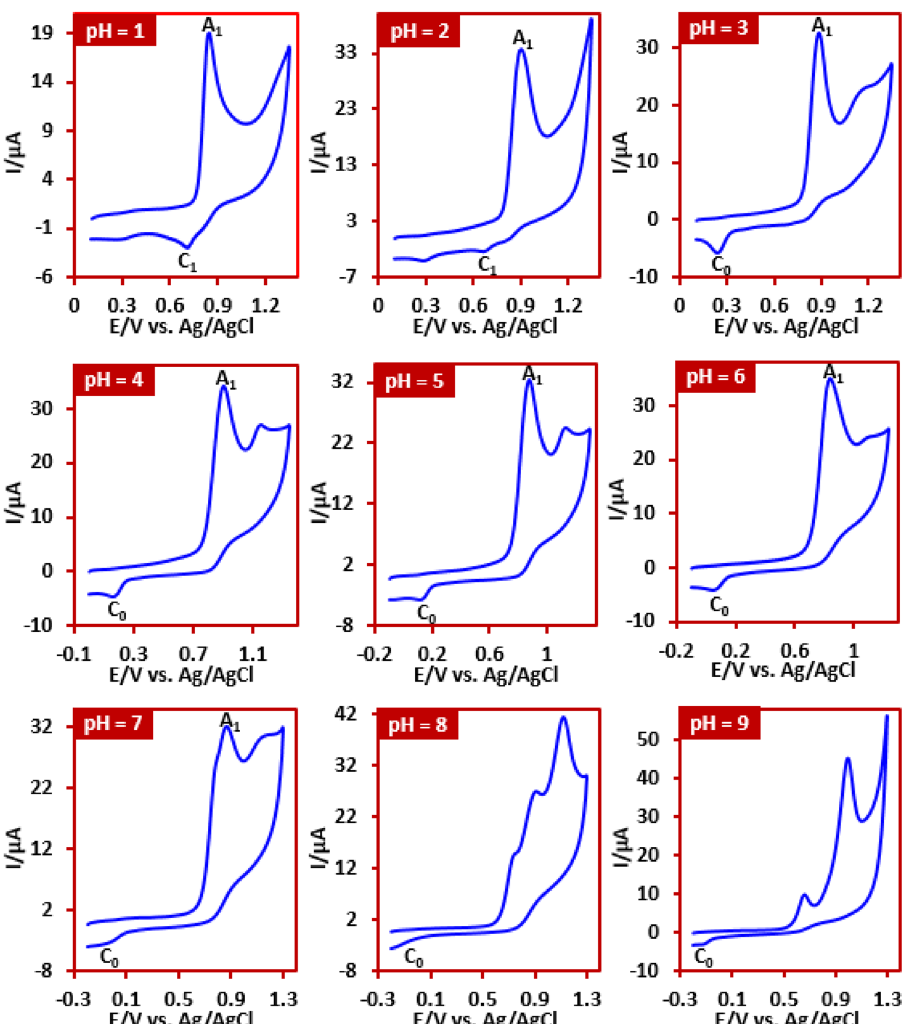
Figure 1. Cyclic voltammograms of IMP (1.0 mM) at glassy carbon electrode in aqueous solutions at different pH values. Scan rate: 100 mV s −1 , at room